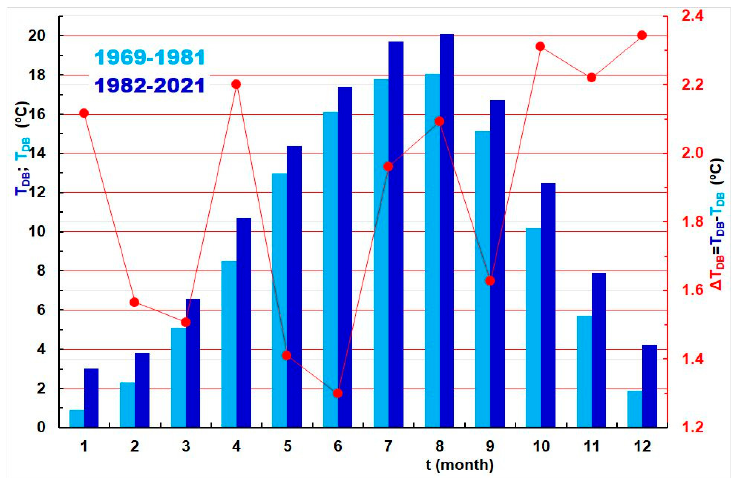
Figure 7. Histograms of average monthly water temperatures of the Drava at the station Botovo, T DB , during the two subperiods: 1969–1981 (light blue color) and 1982–2021 (dark blue color). A line graph of their differences, Δ T DB , for the two subperiods above is shown in red.